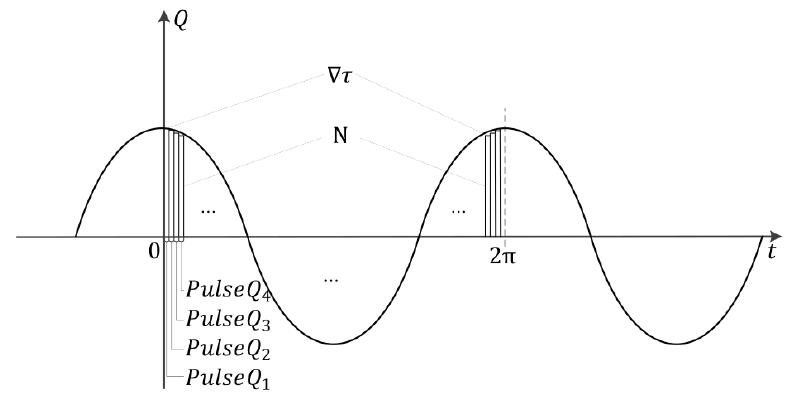
Figure 3. Periodic simple harmonic load excitation discretization. Figure 3. Schematic diagram of pule load formed by differential concentrated load.